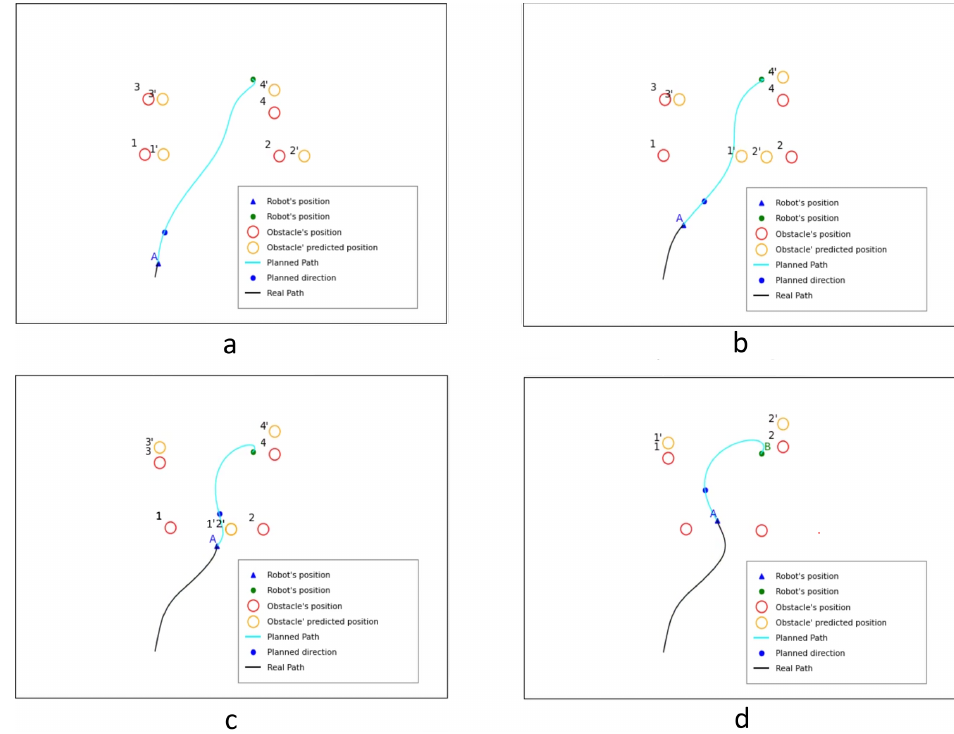
Figure 8. Collision prevention using the improved Bézier curve